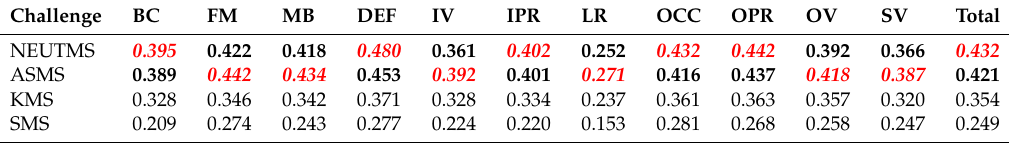
Table 3. AUC results of each tracker on sequences with different challenge for